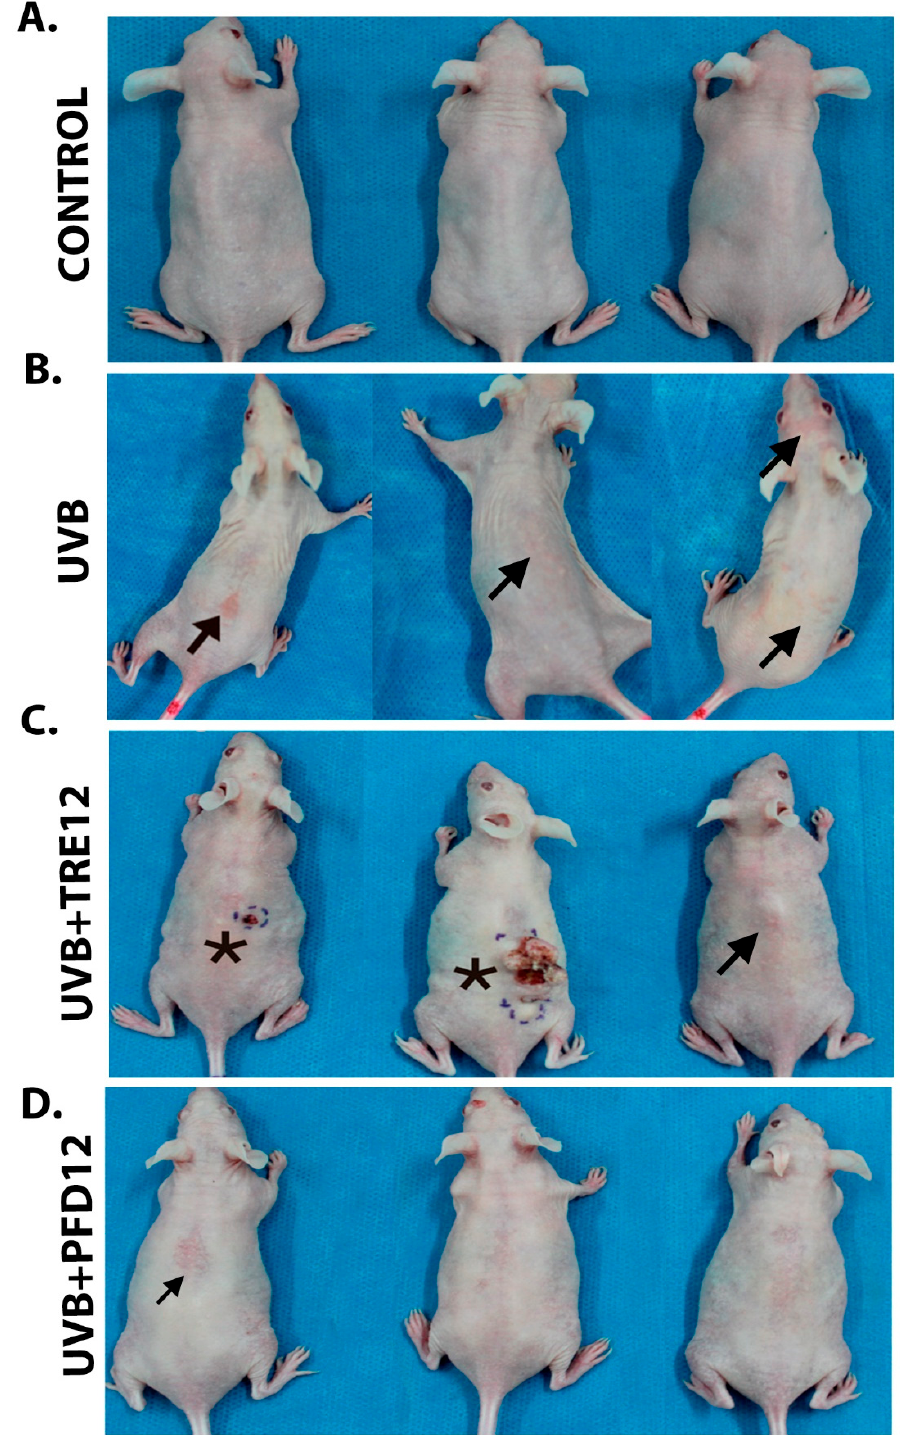
Figure 1. ( A ) Control group mice, animals not exposed to UVB radiation. ( B ) UVB group, mice exposed to UVB radiation, exploration of the dorsal area shows severe inflammatory lesions ( → ). ( C ) UVB + TRE12 group, mice treated with TRE (0.05% Retin-A ® cream) after UVB irradiation, tumor lesions (*) and inflammatory lesions ( → ) are observed. ( D ) UVB + PFD group, mice treated with PFD (8% gel) after UVB irradiation, only mild inflammation is observed.